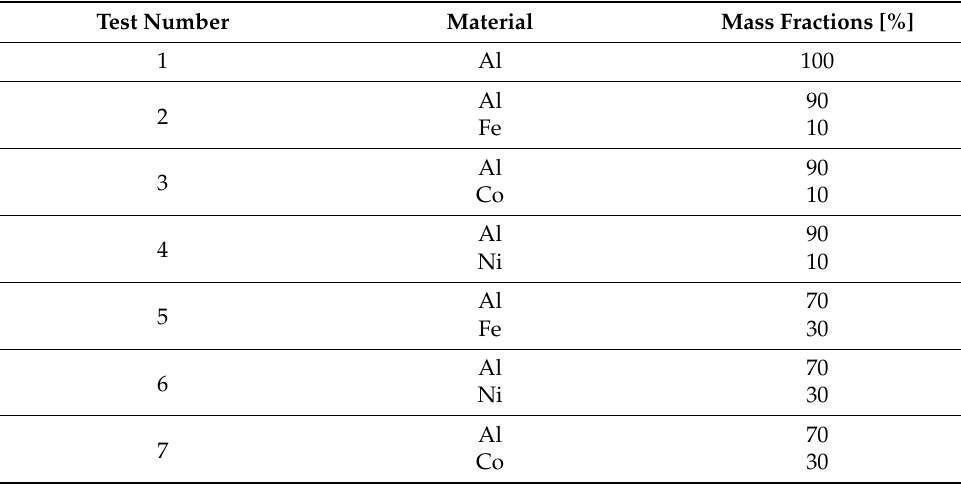
Table 2. Material composition of the hipped